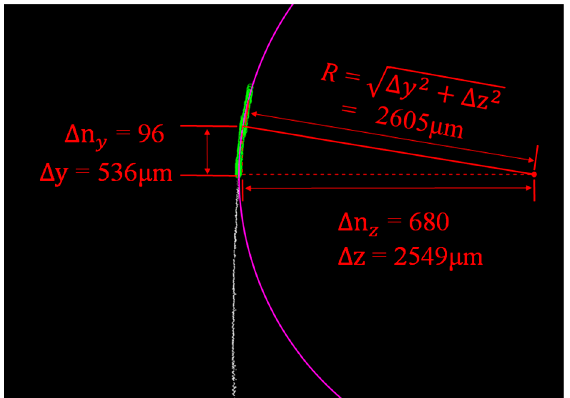
Figure 10. Calculation of the curvature of the opaque mobile phone protective shell through fitting to a circle. The circle radius is calculated by recognizing that Δ y/ Δ n y and Δ z/ Δ n z are the projections of